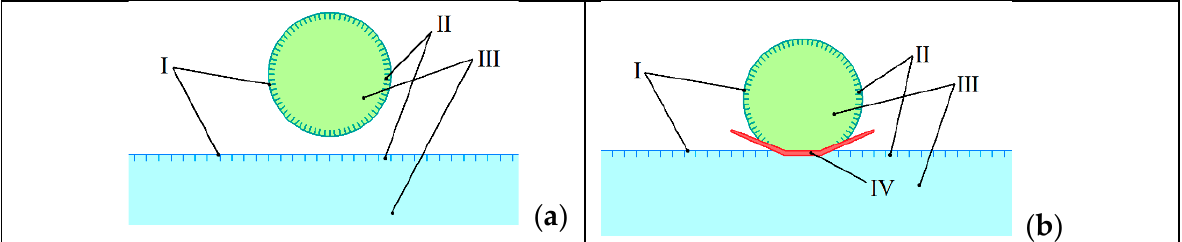
Figure 15. The scheme of the Gibbs potential distribution in the approaching drop and the target fluid as well as at the moment of primary contact, accompanied by the elimination of the contact surfaces of the merging fluids and the transformation of the APSE in other forms: ( a ) at the target fluid and approaching drop, ( b ) at the primary contact: I—surface layers of the target fluid and drop, II—sub-surface layers, III—interior fluid, IV—energy-saturated interface and its continua-